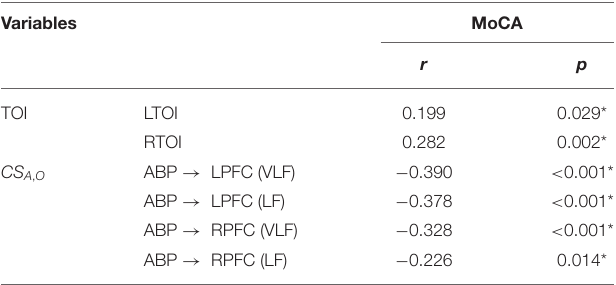
TABLE 2 | Correlations between the MoCA scores, TOI, and CS A , O at rest in the bilateral PFC.